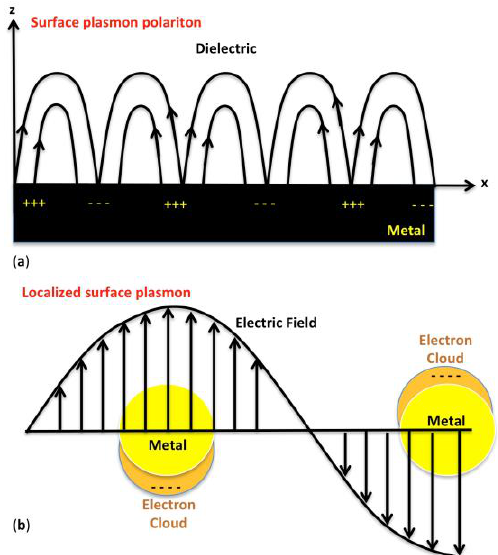
Figure 1. ( a ) Surface plasmon polariton; and ( b ) localized surface